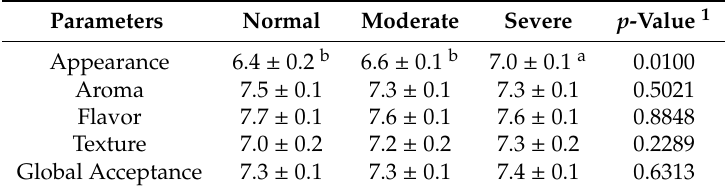
Table 6. Sensory scores ( + SEM) of hamburgers produced with chicken breast of Ross broiler chickens (AP95) without myopathies and a ff ected by wooden breast